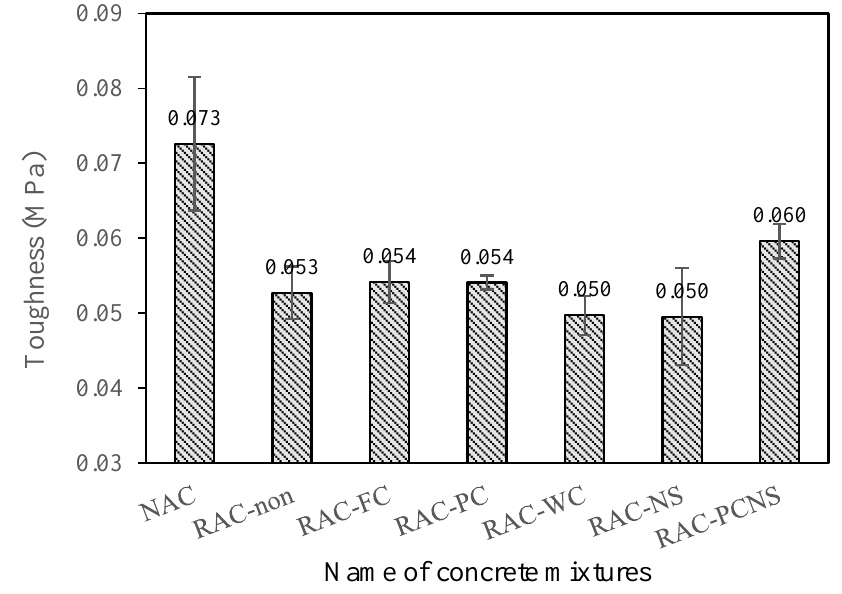
Figure 10. Toughness of hardened concretes.